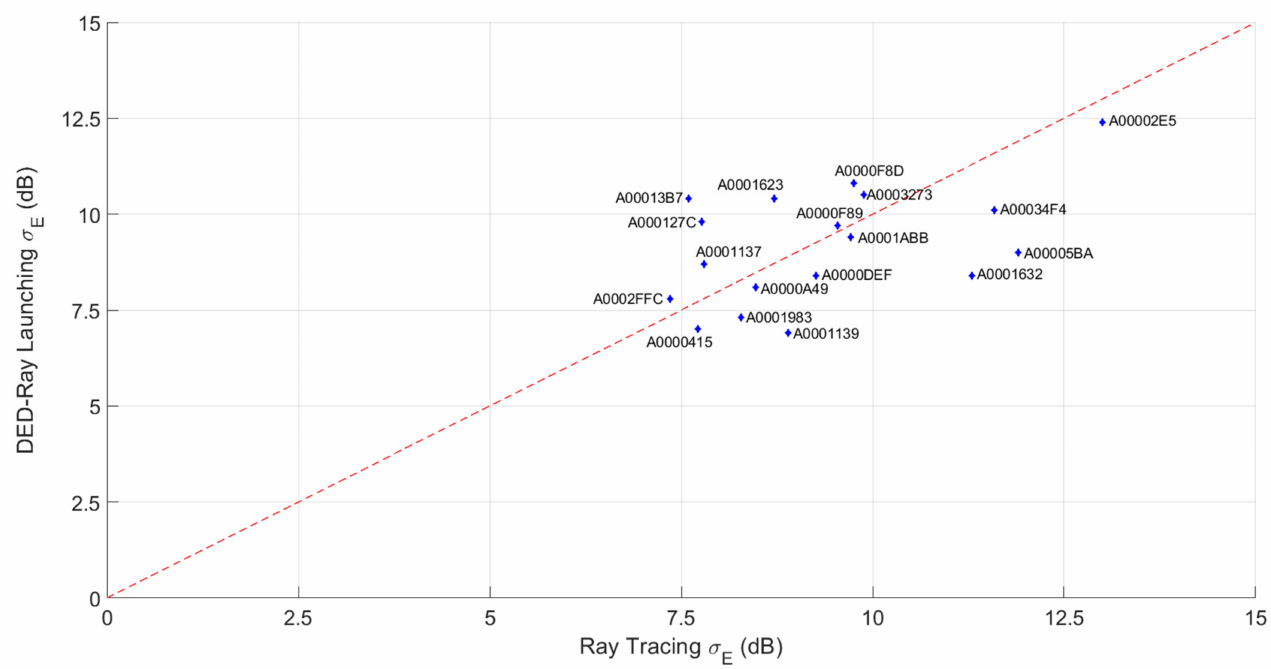
Figure 5. Performance Comparison of DED-RL with image RT, in terms of error standard deviation ( σ E ) for the 18 BS analyzed in [6]. 5 × 5 m 2 tiles are considered in DED-RL